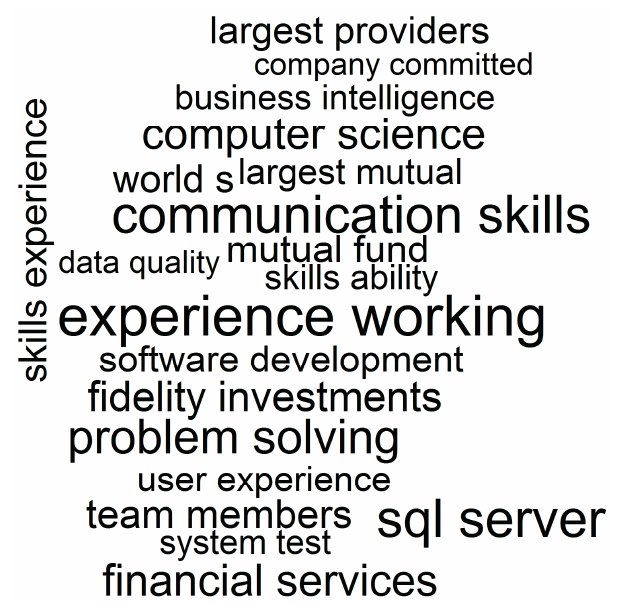
Figure 15. Job Descriptions Visualization—Developer (unseen data).